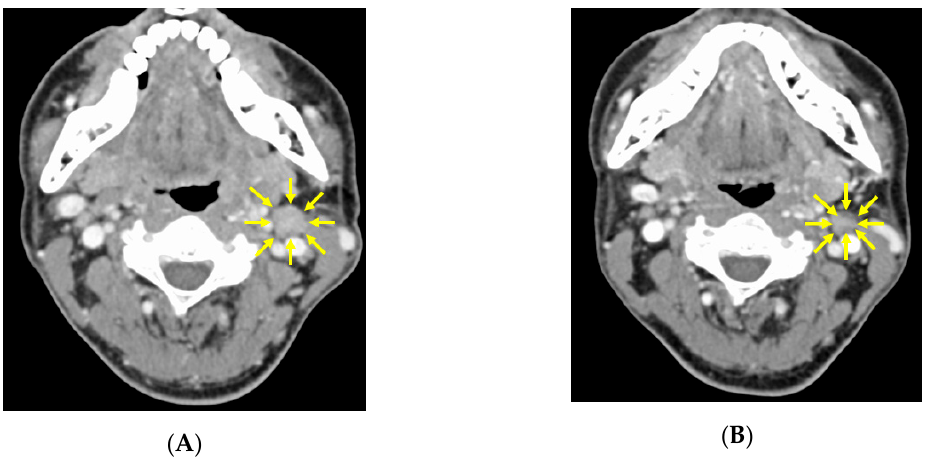
Figure 3. CT imaging findings of the left cervical lymph node region before and after neoadjuvant chemotherapy. ( A ) Before neoadjuvant chemotherapy, a 12 × 13 mm swollen lymph node is evident in the left upper internal deep cervical lymph node region (arrows). ( B ) After the second neoadjuvant chemotherapy course, the enlarged lymph node has shrunk to 10 × 10 mm (arrows).